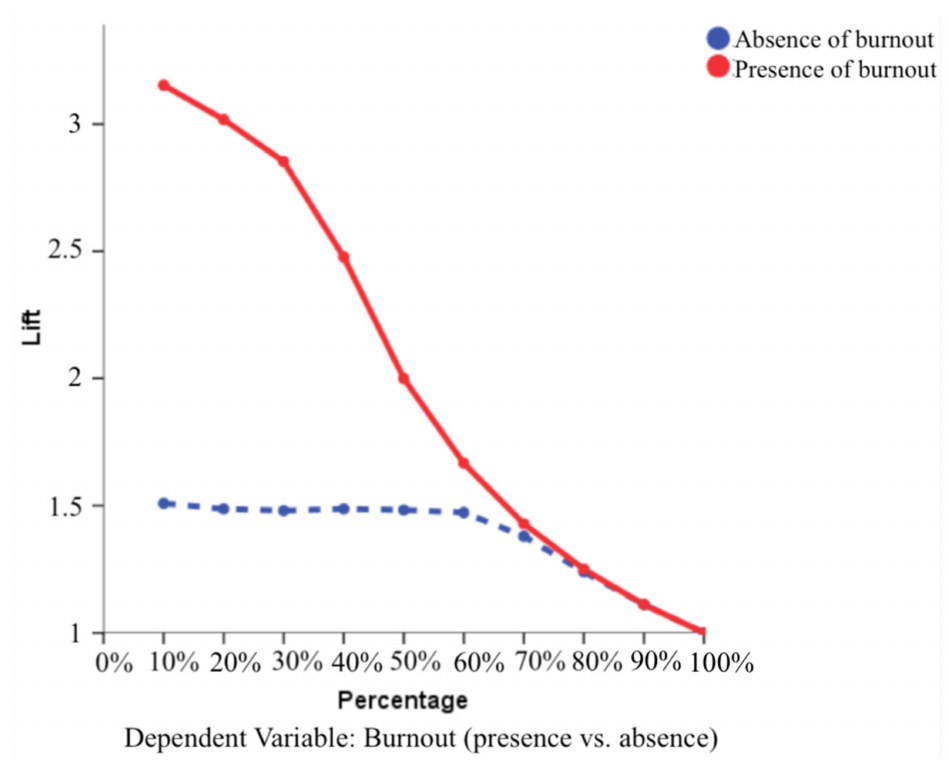
Figure 4. Artificial neural network